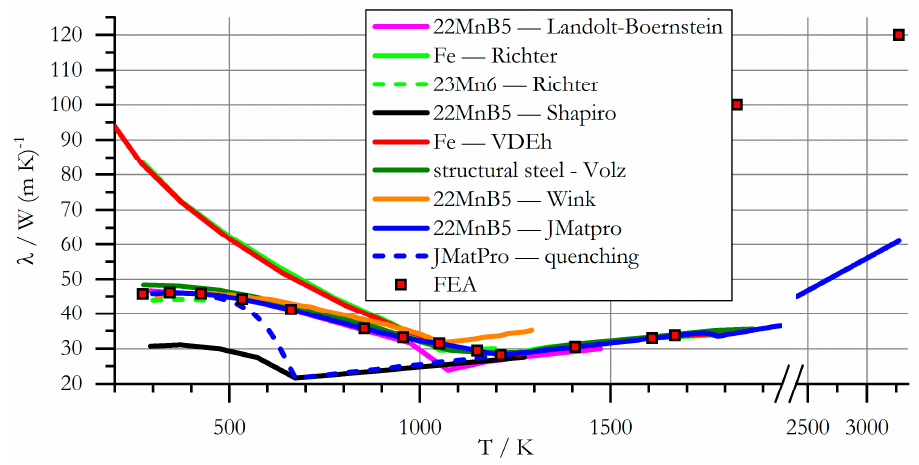
Figure 13. Specific thermal conductivity of 22MnB5.